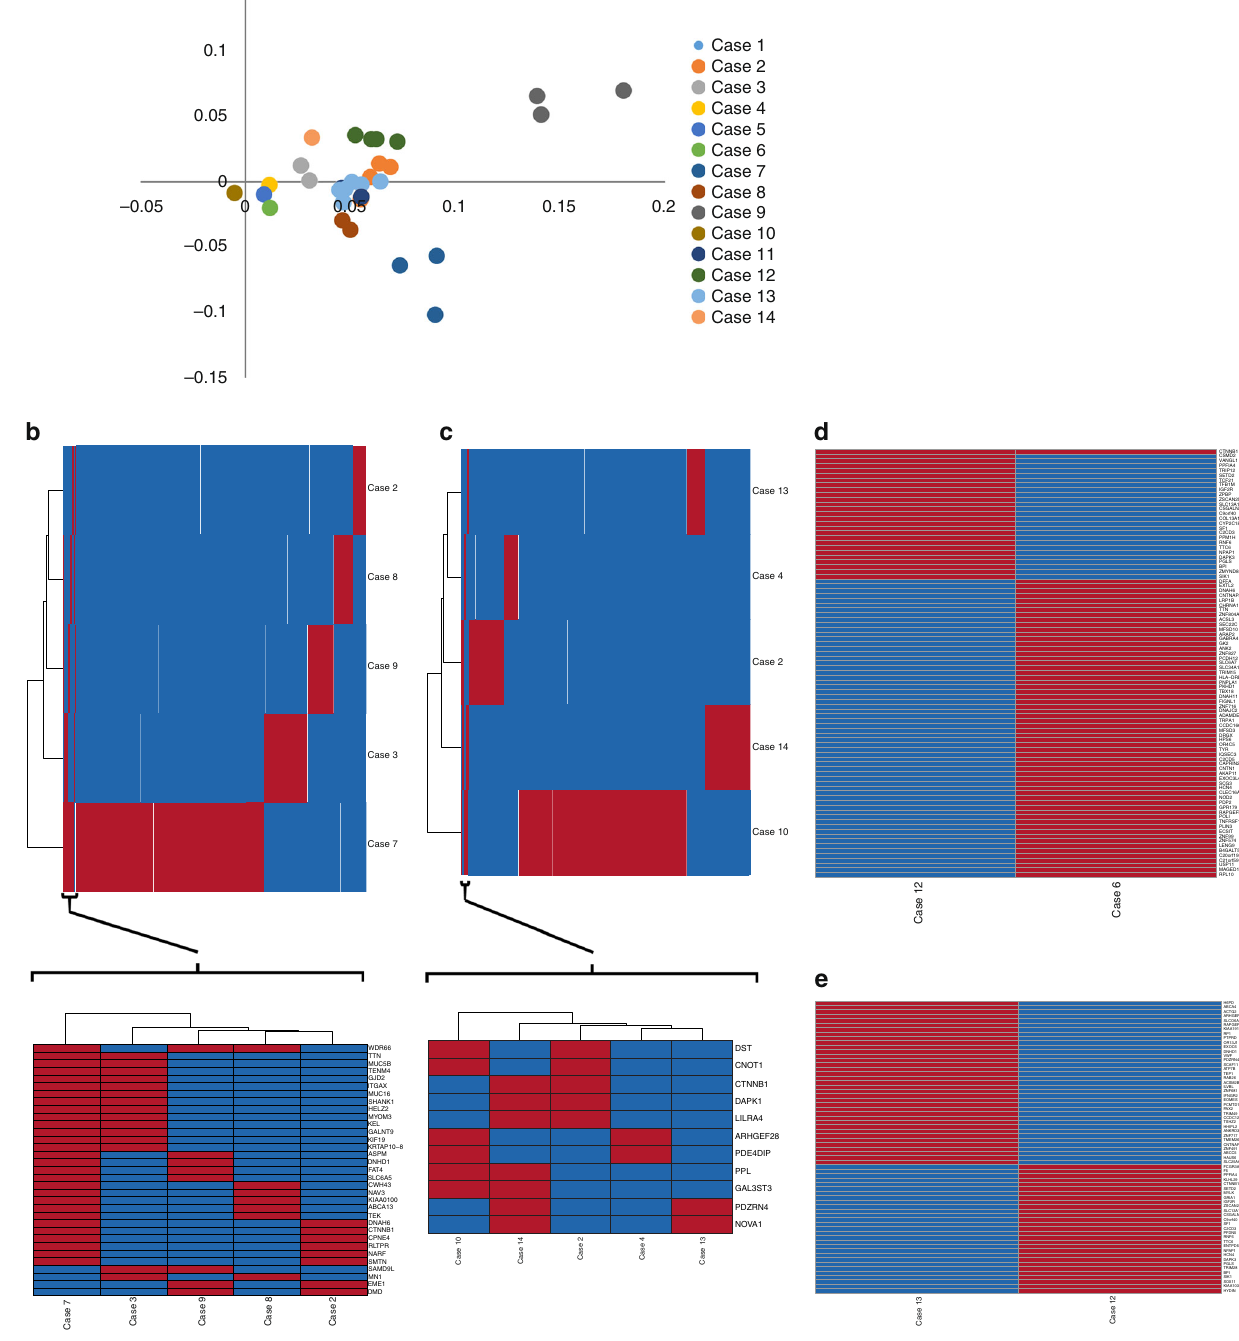
Fig. 2 Genotyping of metastatic ACC shows tumor heterogeneity among different metastatic tumor sites. The principal component analysis (PCA) of all the missense, nonsense, and splice site mutations in 33 metastatic adrenocortical tumors ( a ). Heatmap and clustering of the overlapping variants within the genes in metastatic lung ( b ) and other tumor sites ( c ) from fi ve different patients (Case 1 with hypermutation phenotype was excluded). The region containing maximum similarity was reanalyzed to better represent the shared genes that are mutated. Heatmap of the total number of overlapping and non-overlapping variants within the genes that are mutated in multiple patients with metastasis in liver ( d ), and peritoneum ( e ). Red bar in the heatmap indicates the gene is mutated, whereas the blue represents that the corresponding gene is wild-type in each